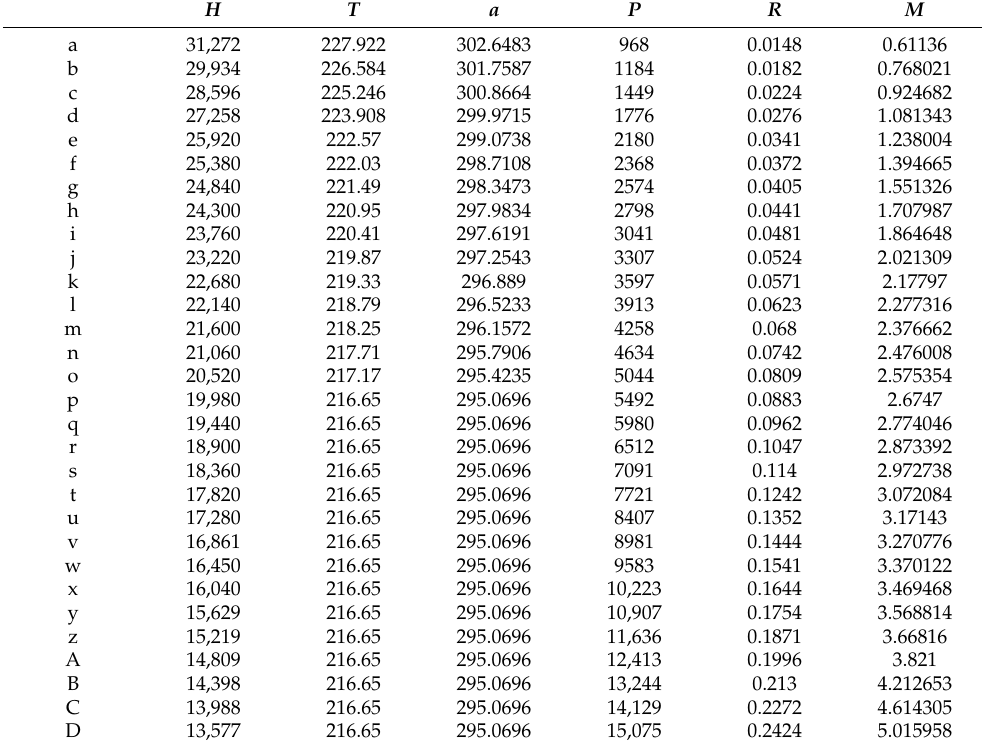
Figure 3. The two-dimensional outflow fields with different attack angles: ( a ) 0°; ( b ) 5°; ( c ) 10°, and ( d ) partially enlarged drawing of the hypersonic flying object’s warhead with different calculated objects: Wall 0, Wall 1, and Wall 2. Table 1. The flight trajectory of the hypersonic flying object and corresponding atmospheric